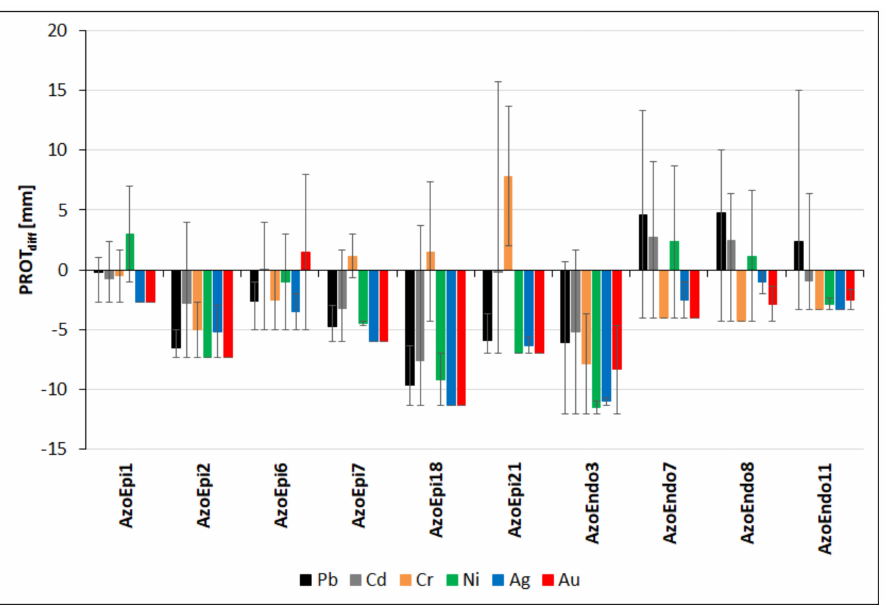
Figure 8. Effect of the metals applied in the specified range of doses (in mg L − 1 ) on the proteolytic activities of the selected strains expressed as differences in the size of halos (in mm) vs. the untreated control. Positive values of bars—stimulation of the activity; negative values of bars—inhibition of the activity. Positive whisker—maximum difference; negative—minimum. See Table 1 for strain